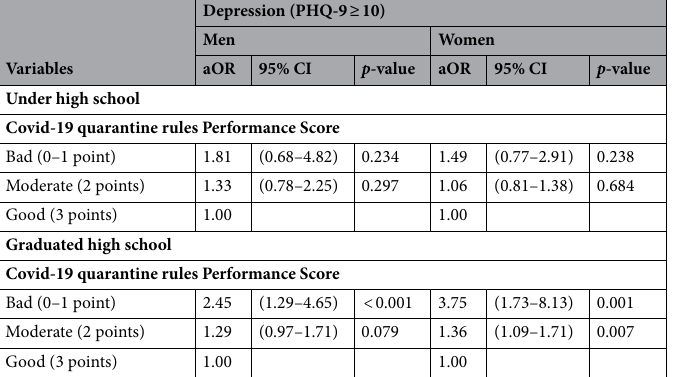
Table 4. Association between COVID-19 quarantine rules performance score and depression according to the education level. Adjusted with all covariates. PHQ-9 Patient Health Questionnaire-9; aOR adjusted odds ratio; CI confidence